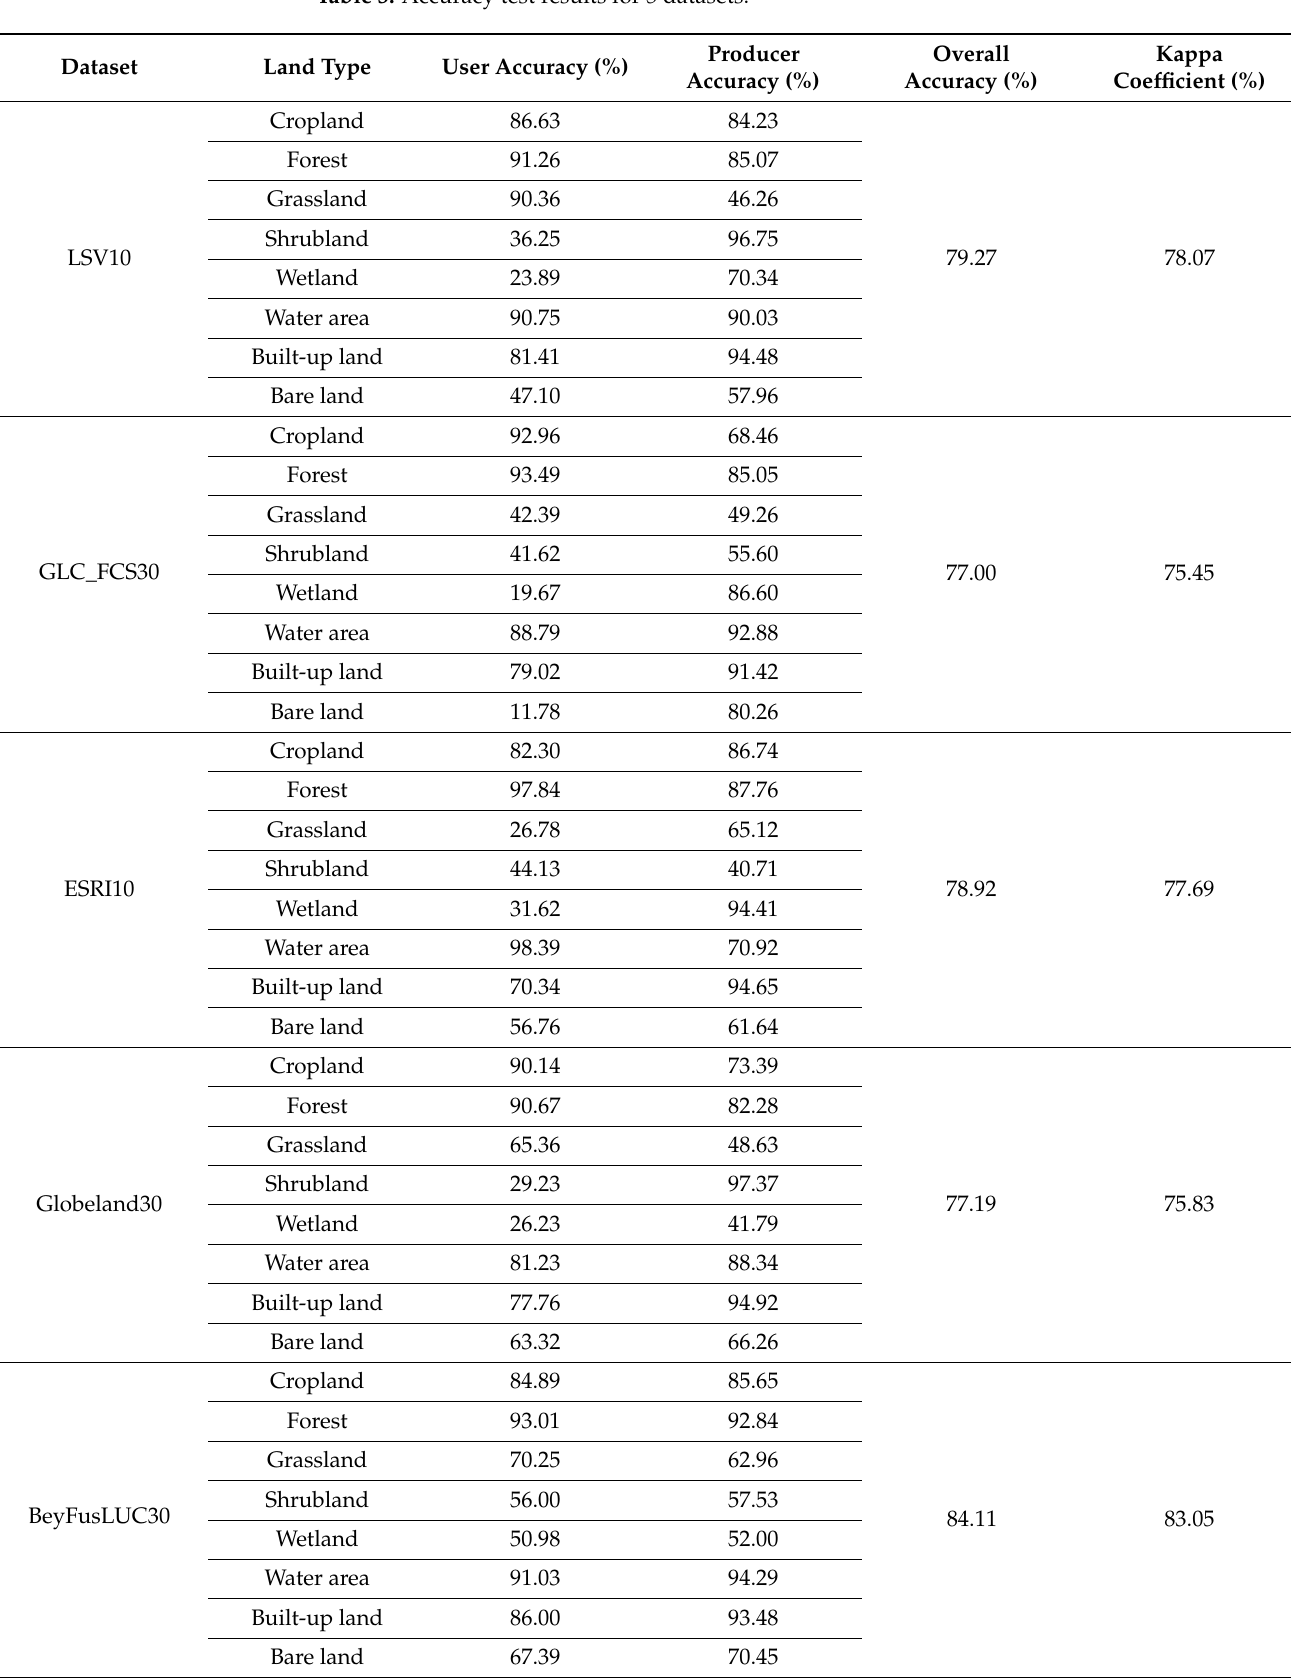
Table 3. Accuracy test results for 5